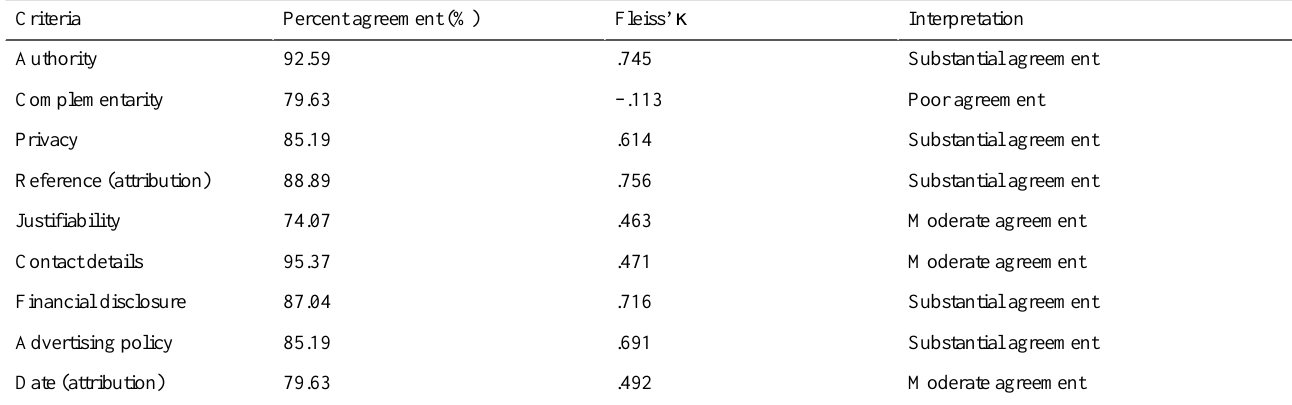
Table 5. Interrater agreement, percent versus Fleiss’ kappa ( κ